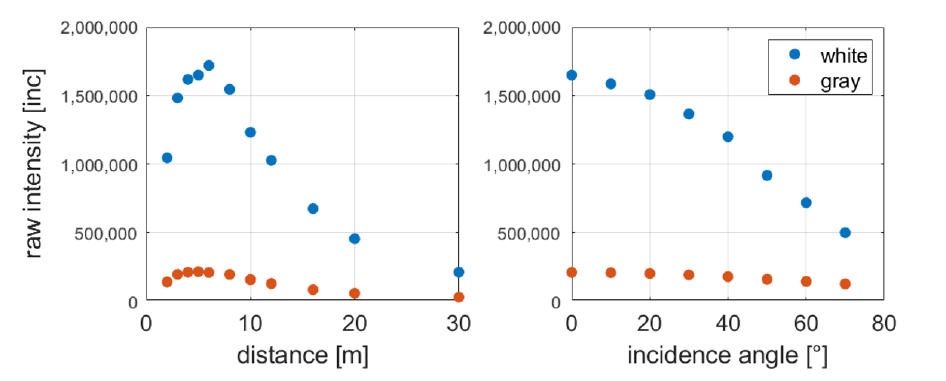
Figure 7. Left : Relation between raw intensity and range; Right : Relation between raw intensity and incidence angle for the Leica